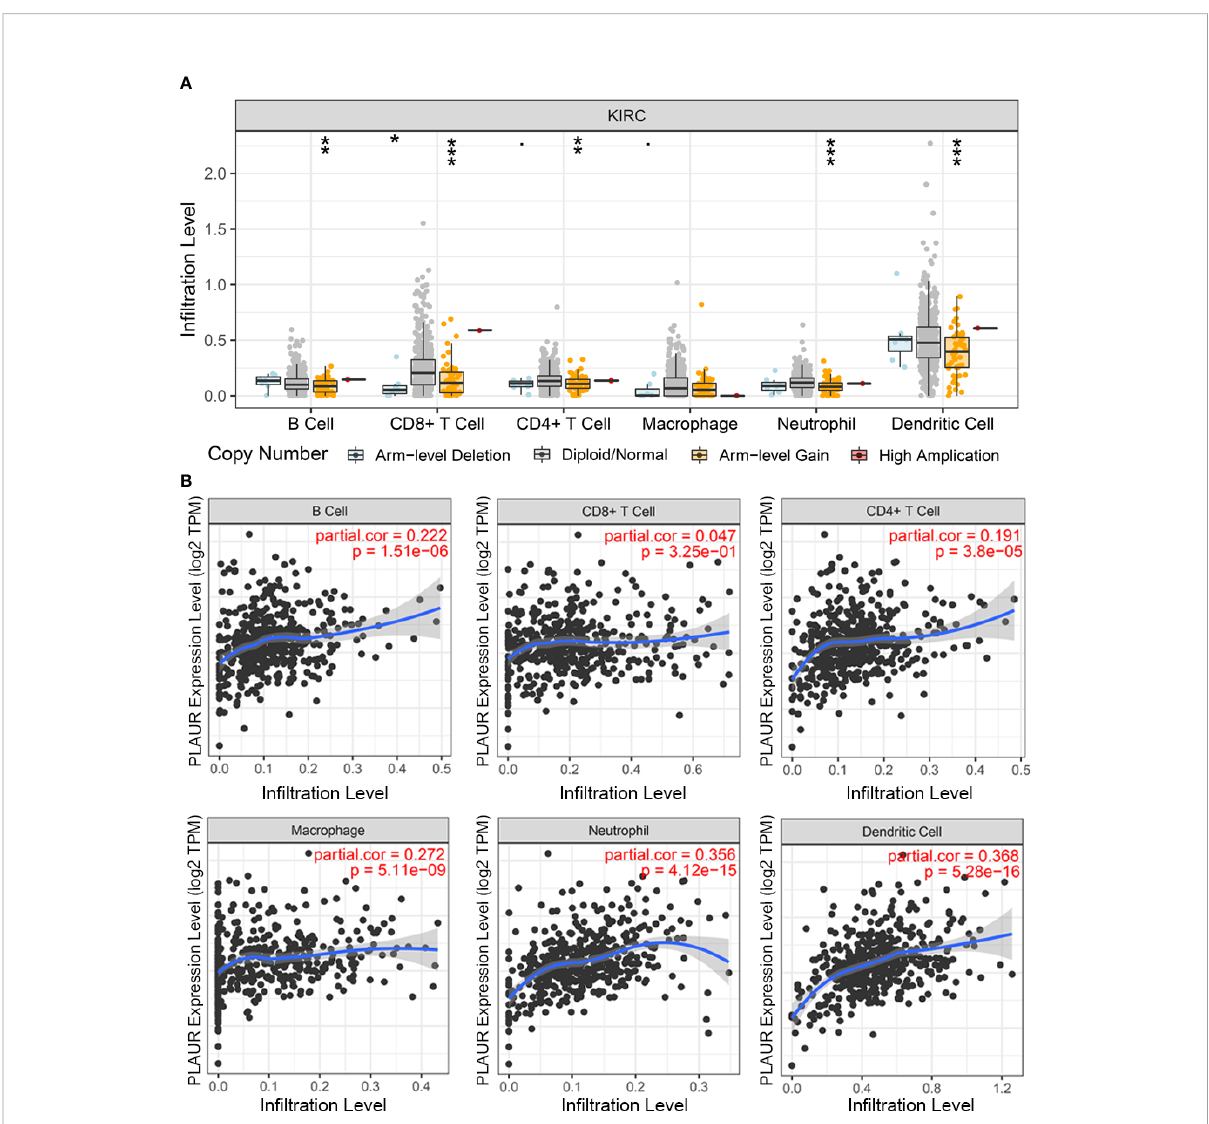
FIGURE 6 The relationship between expression of PLAUR and immune cell in fi ltration in KIRC. (A) Association between PLAUR gene copy number and immune cell in fi ltration levels in KIRC. (B) The relationship of PLAUR expression with six various in fi ltrating immune cells in KIRC. *p<0.05; **p<0.01;